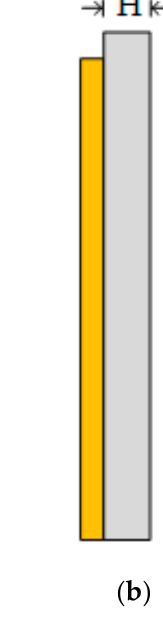
Figure 1. Configuration of the proposed antenna: ( a ) Front view and ( b ) side view. Table 1. Optimized parameters of the antenna. Parameter